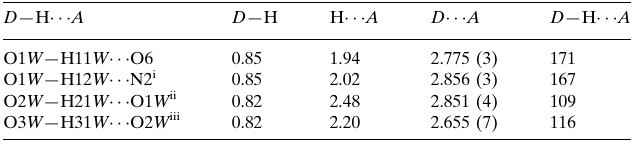
Hydrogen-bond geometry (A˚ , (cid:2)